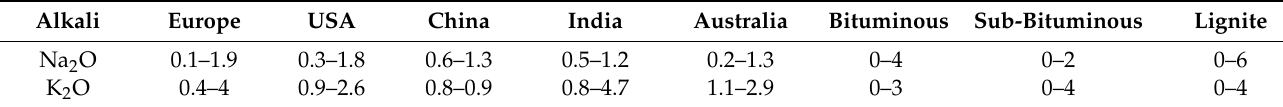
Table 1. Coal fly ash alkalis by region and coal type